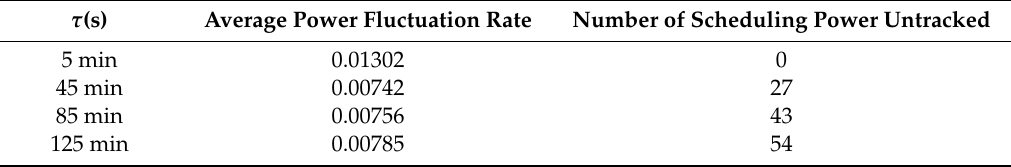
Figure 13. Total charging power of aggregated EVs under different filter time constants.